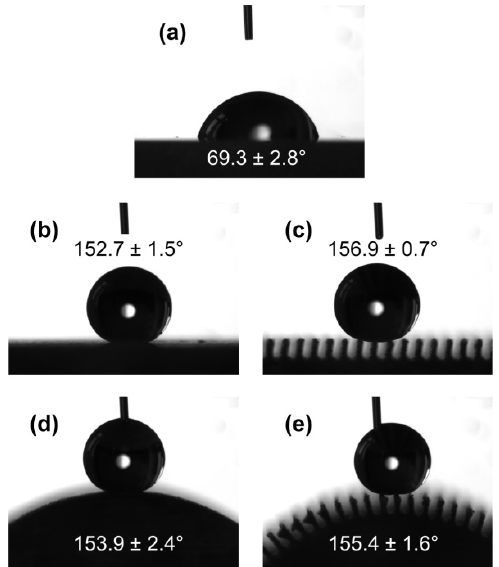
Figure 6. Contact angles of a water droplet on different aluminum alloy surfaces: ( a ) Polish surface; ( b )–( e ) dual-level structured plane surface, three-level structured plane surface, dual-level structured convex surface, and three-level structured convex surface after Never Wet treatment.